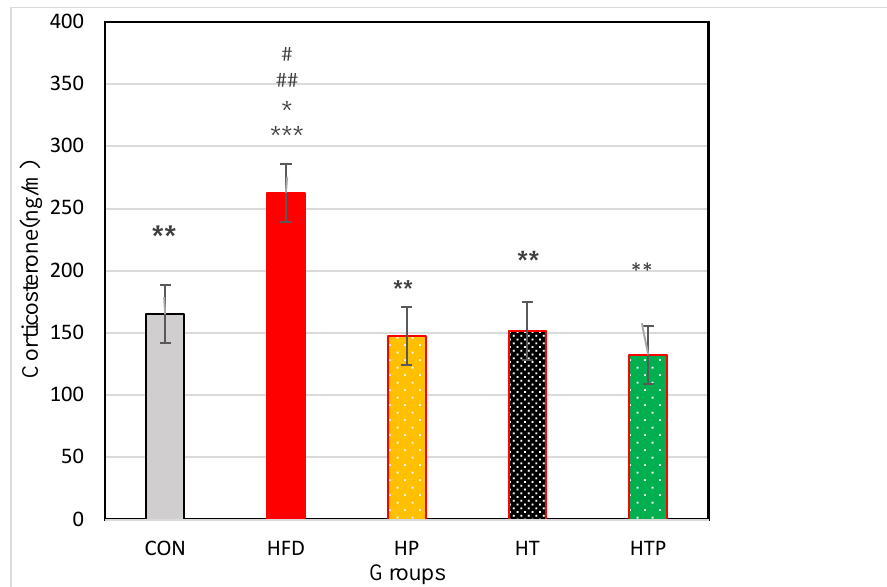
Figure 2. Comparison of the VFM of C57BL/6 mice (Mean ± SE) in experimental groups. * p < 0.05: significant difference with CON group; ** p : significant difference with HFD; *** significant difference with HP group; #: significant difference with HT group; ##: significant difference with HTP group; CON: control, HFD: high-fat diet, HP: high-fat diet+ probiotic, HT: high-fat diet +HIIT training, HTP: high-fat diet+ HIIT training+ probiotic.